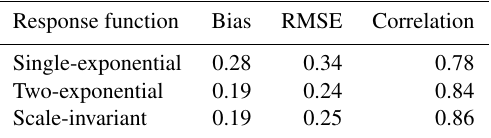
Table 1. The average absolute value of the bias, the root mean square error, and the correlation obtained when comparing the marginal posterior mean estimates of the TCR with the TCR ob- tained directly from the